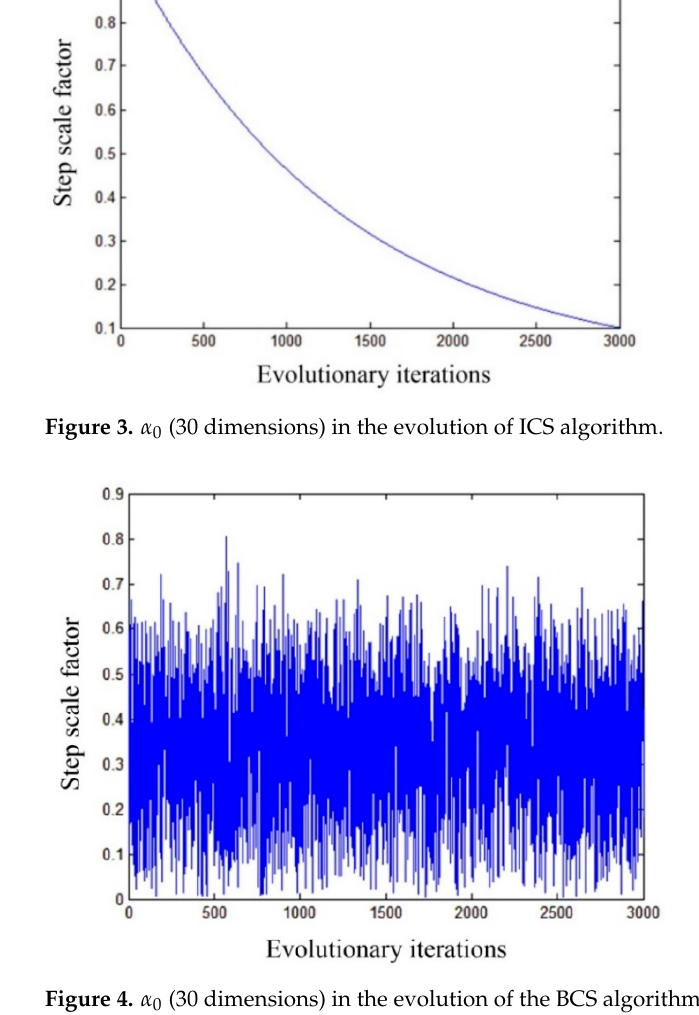
Figure 5. 𝛼 (cid:2868) (30 dimensions) in the evolution of ABCS algorithm.